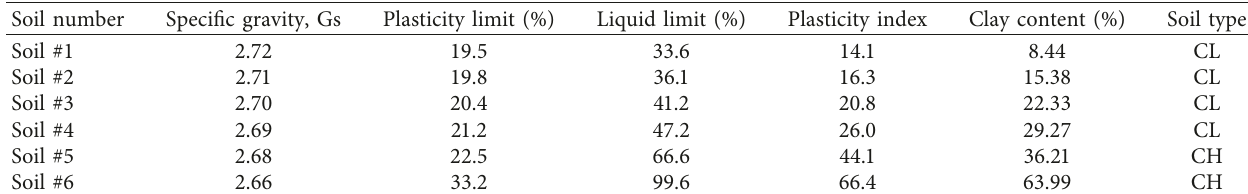
Table 1: Soil physical properties.